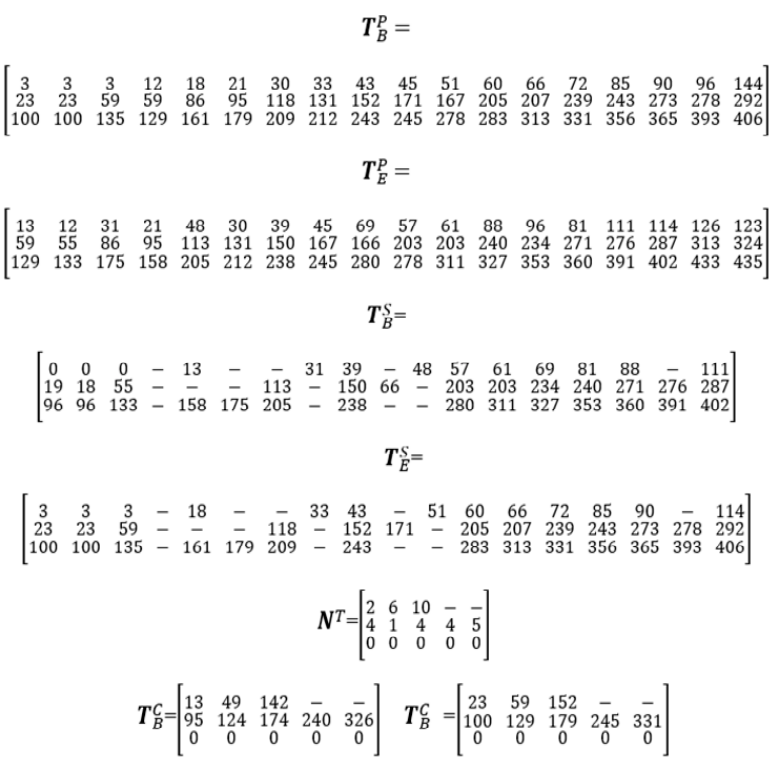
Figure 11. Production operation plan.